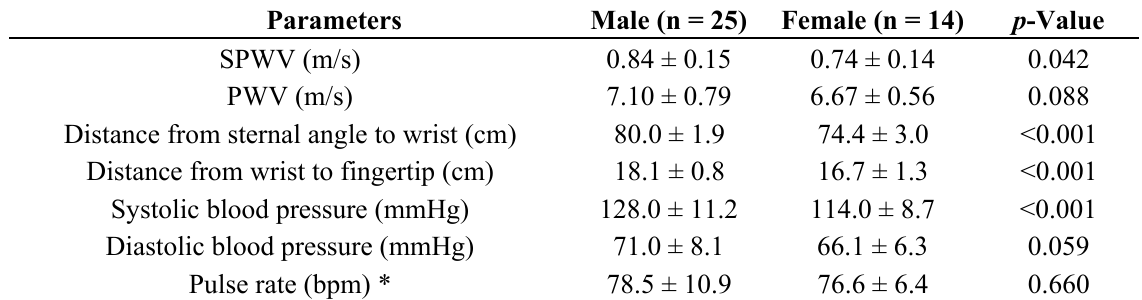
Table 1. Differences of SPWV and PWV between males and females.